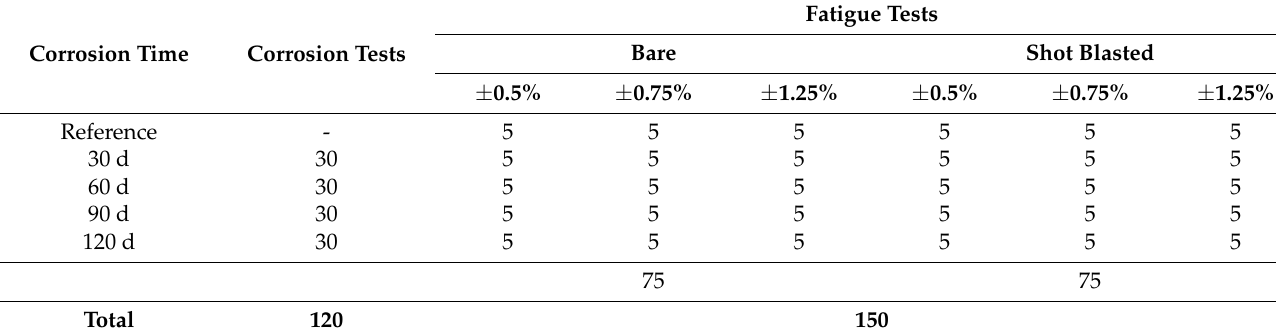
Table 5. Test matrix for bare and shot blasted